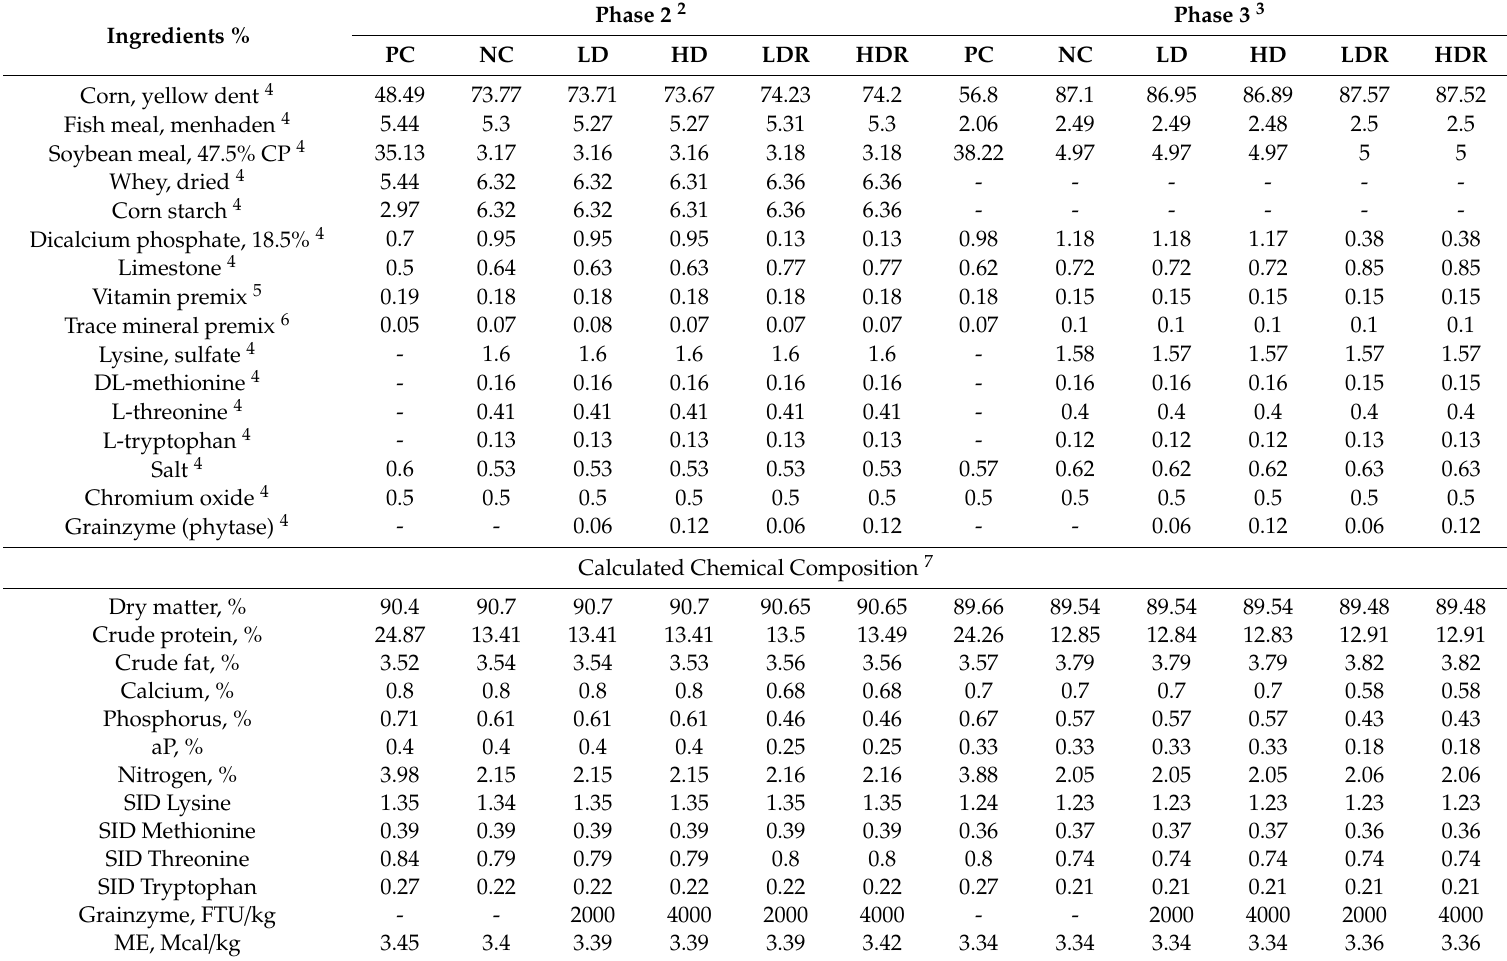
Table 1. Ingredients and composition of experimental diets 1 (% as-fed basis)